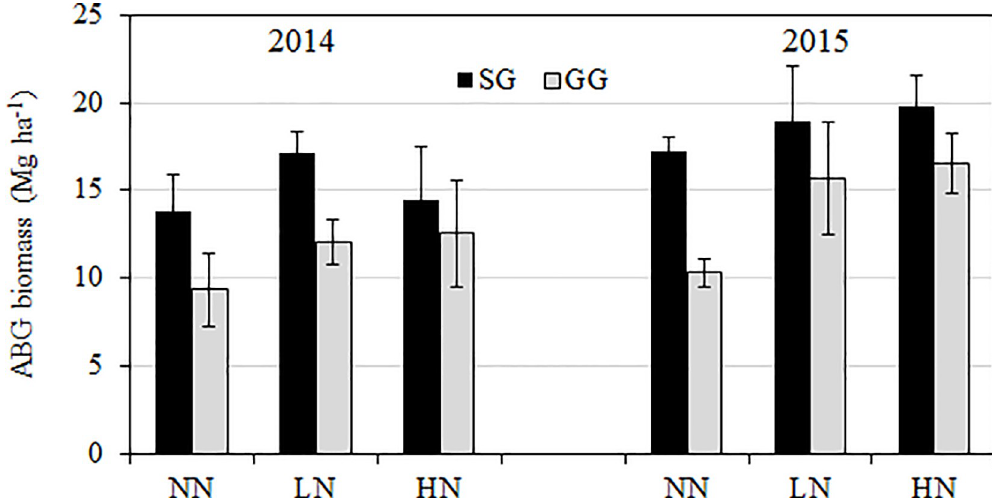
Fig 1. Mean ( ± SE) plant ABG biomass (Mg ha -1 ) under three fertilization treatments (e.g, NN, LN and HN) in SG and GG croplands in 2014 and 2015. There was only significant crop type effect on ABG biomass in each collection year (Table 1). Each bar represents a mean value of four replicates (n = 4). NN: no N input; LN: low N input (84 kg N ha -1 in urea); HN: high N input (168 kg N ha -1 in urea); ABG: